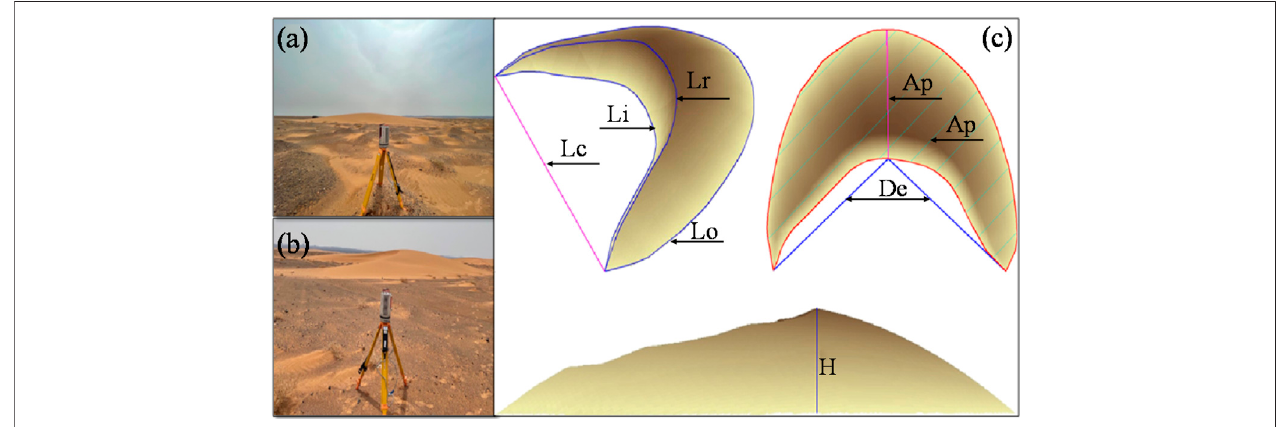
FIGURE 2 | Schematic diagram of the extraction of the morphological parameters of the barchan dunes. Panel (A,B) represents the fi eld measurement of sand dunes, and panel (C) represents the schematic diagram of morphological parameters of sand dunes.